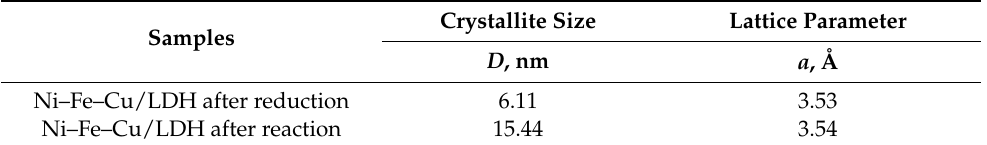
Figure 11. XRD profile of Ni–Fe–Cu/LDH ( a ) after reduction and ( b ) after reaction: ( ) Ni metal, ( ) Ni–Fe alloy, ( ) MgO- like phase, ( • ) NiO. Table 8. Crystallite size and lattice parameters of Ni particles of Ni–Fe–Cu/LDH after reduction and after